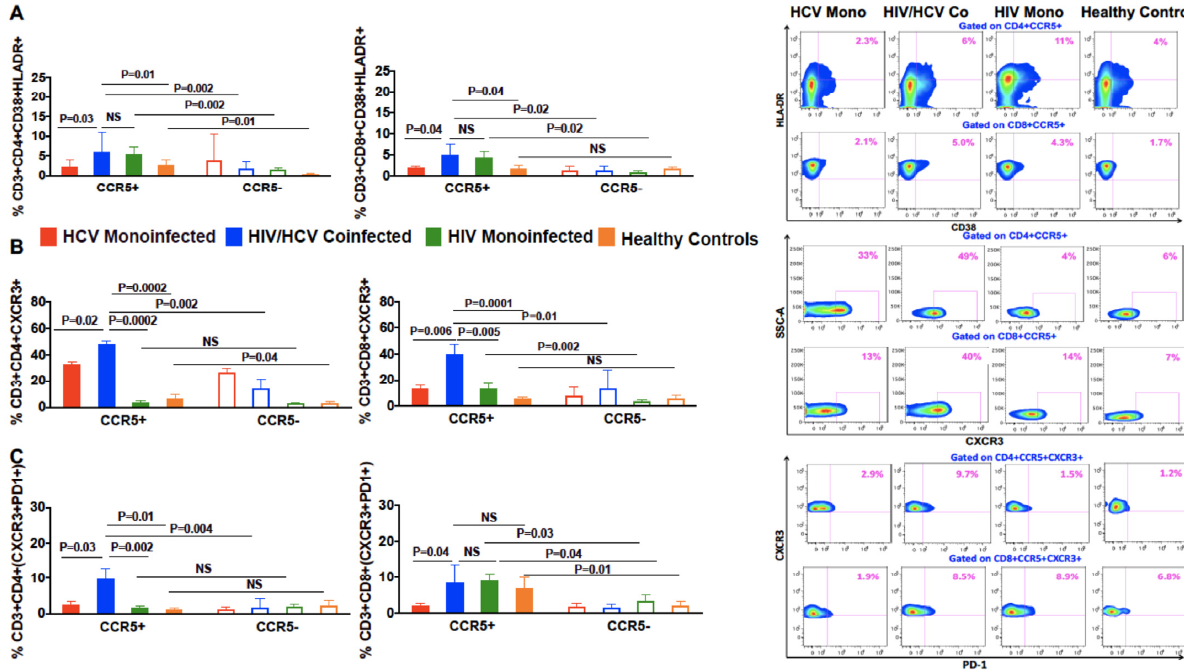
Figure 2. Differences in the frequencies of CD38/HLADR, CXCR3 and PD1+CXCR3+ on CCR5+ and CCR5 negative CD4+ and CD8+ T cells in patients with HIV/HCV coinfection and HCV monoinfection. Flow cytometry plots of a patient and bar graphs with HCV monoinfection, HIV/HCV coinfection, HIV monoinfection and healthy controls demonstrating the differences in the percentages of ( A ) CD38+HLADR+ on CD4+CCR5+ and CD8+CCR5+ T cells ( B ) CXCR3 on CD4+CCR5+ and CD8+CCR5+ T cells ( C ) CXCR3+PD1+ on CD4+CCR5+ and CD8+CCR5+ T cells. Data are expressed as (mean ± SEM) and differences in the percentage of T cells expressing different markers between the two groups were analyzed using a non-parametric Mann–Whitney test in Graph Pad Prism version 6. The Wilcoxon matched-pair signed rank test was used for analyzing the differences between the CCR5+ and CCR5 negative T cells within the same group. p values less than 0.05 were considered